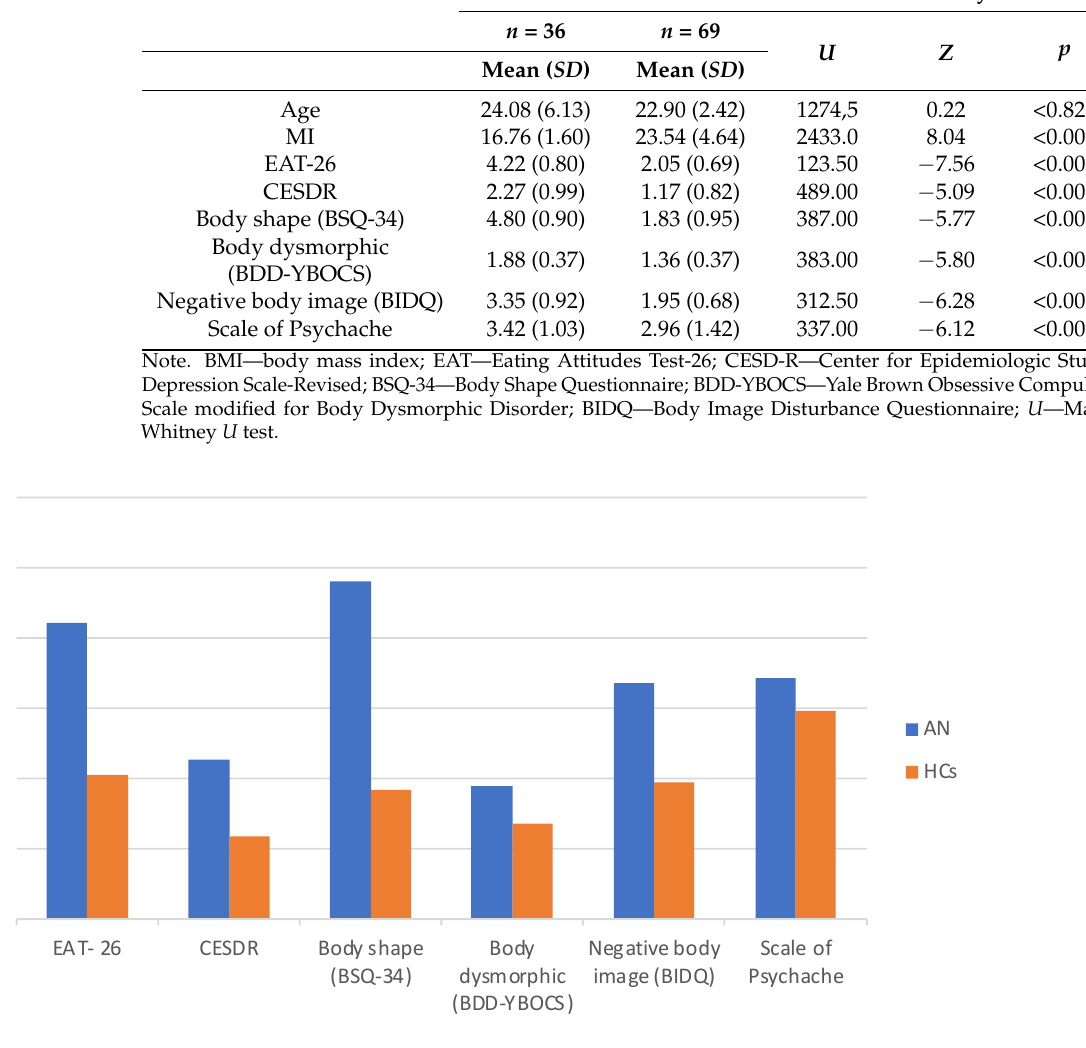
Figure 1. Clinical data for the two subject groups. EAT-26—Eating Attitude Test-26, CESD-R—Center for Epidemiologic Studies Depression, BSQ-34—Body Shape Questionnaire Scale-Revised,